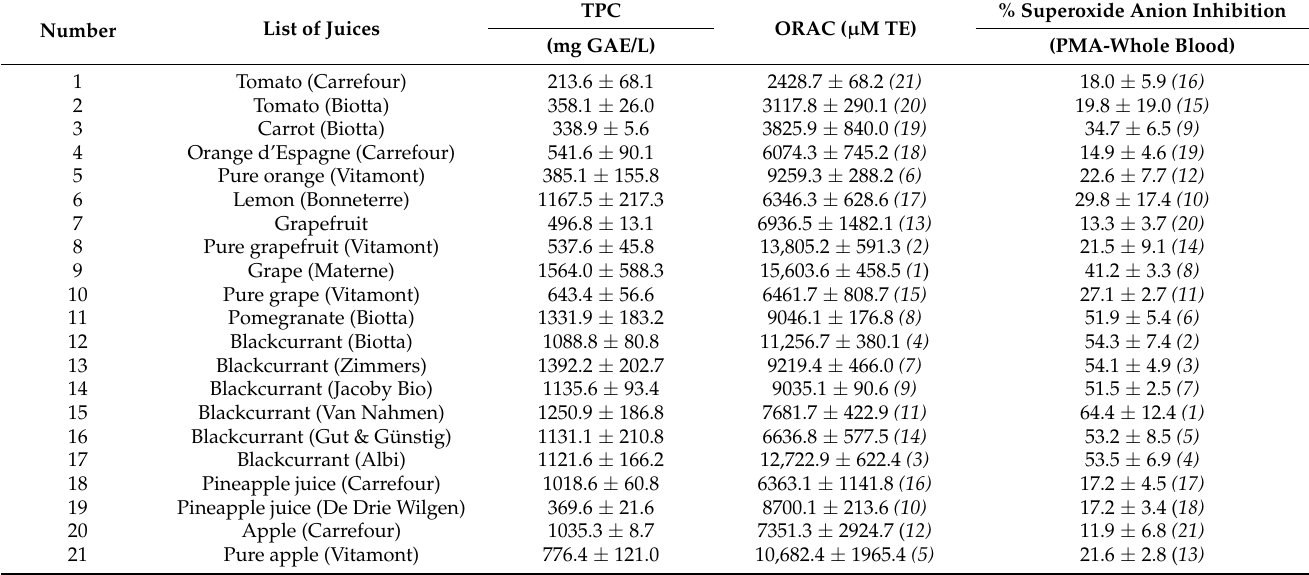
Table 1. Total polyphenol content (TPC) [28], Oxygen Radical Capacity (ORAC) values, and % of superoxide anion inhibition by PMA-activated-whole blood assay of 21 commercial fruit and vegetables juices ( n = 3 for TPC and ORAC assay; n = 4 for % superoxide anion inhibition). Italic numbers into brackets indicate the ranking from highest to lowest antioxidant capacity of all juices according to the test